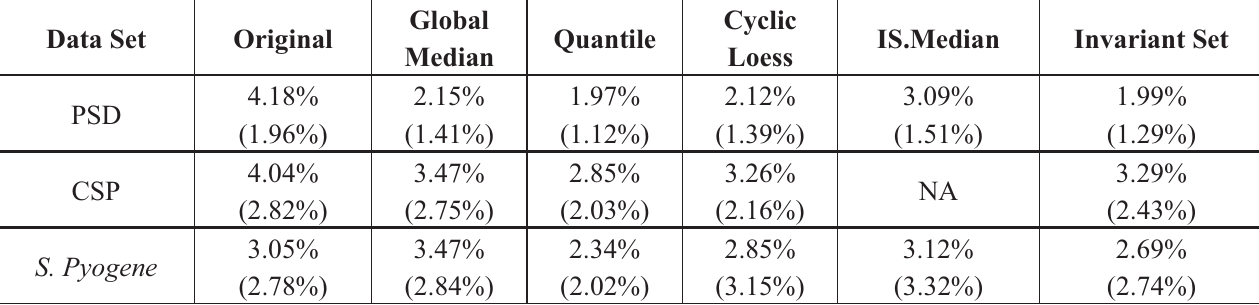
Table 1. Median coefficient of variation for the five normalization methods considered (with median absolute